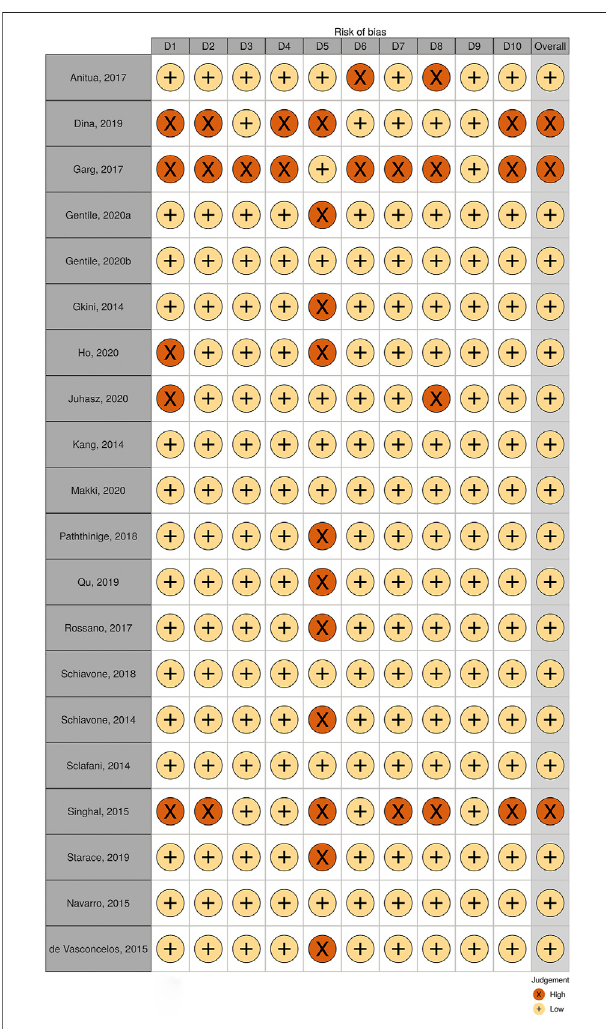
FIGURE 4 | Risks of Bias evaluation of case series.